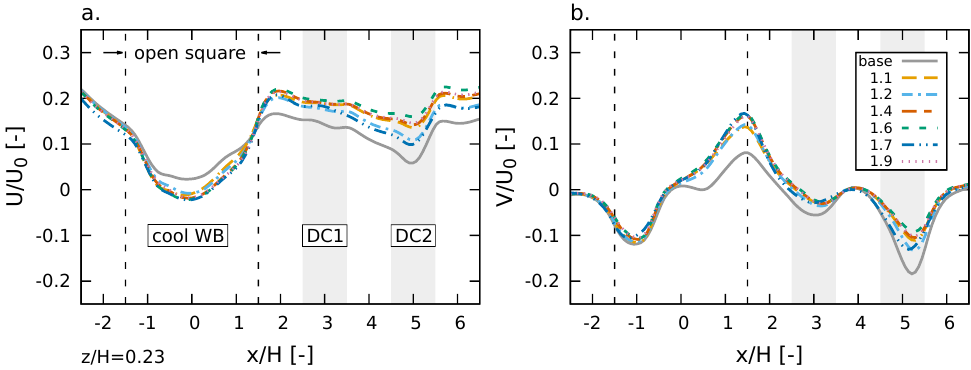
Figure 17. Profiles of ( a ) normalised streamwise ( U / U 0 ) and ( b ) normalised spanwise ( V / U 0 ) velocity over a horizontal line in the middle of the street canyon ( y / H = 1) at pedestrian level ( z / H = 0.23) for the cool water body cases ( ∆ T = − 2K) and different water body shapes. The shaded areas denote the position of the downwind canyons DC1 and DC2. The location of the open square is shown with the vertical dotted